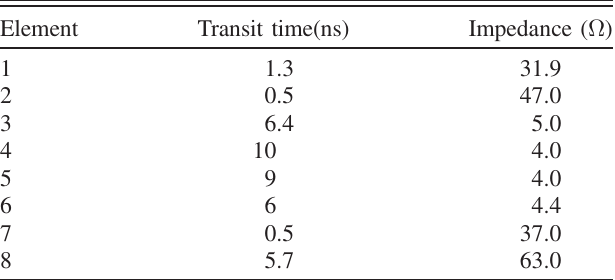
TABLE III. Transit time in nanosecond and impedance in ohm for the transmission line elements in PFL.